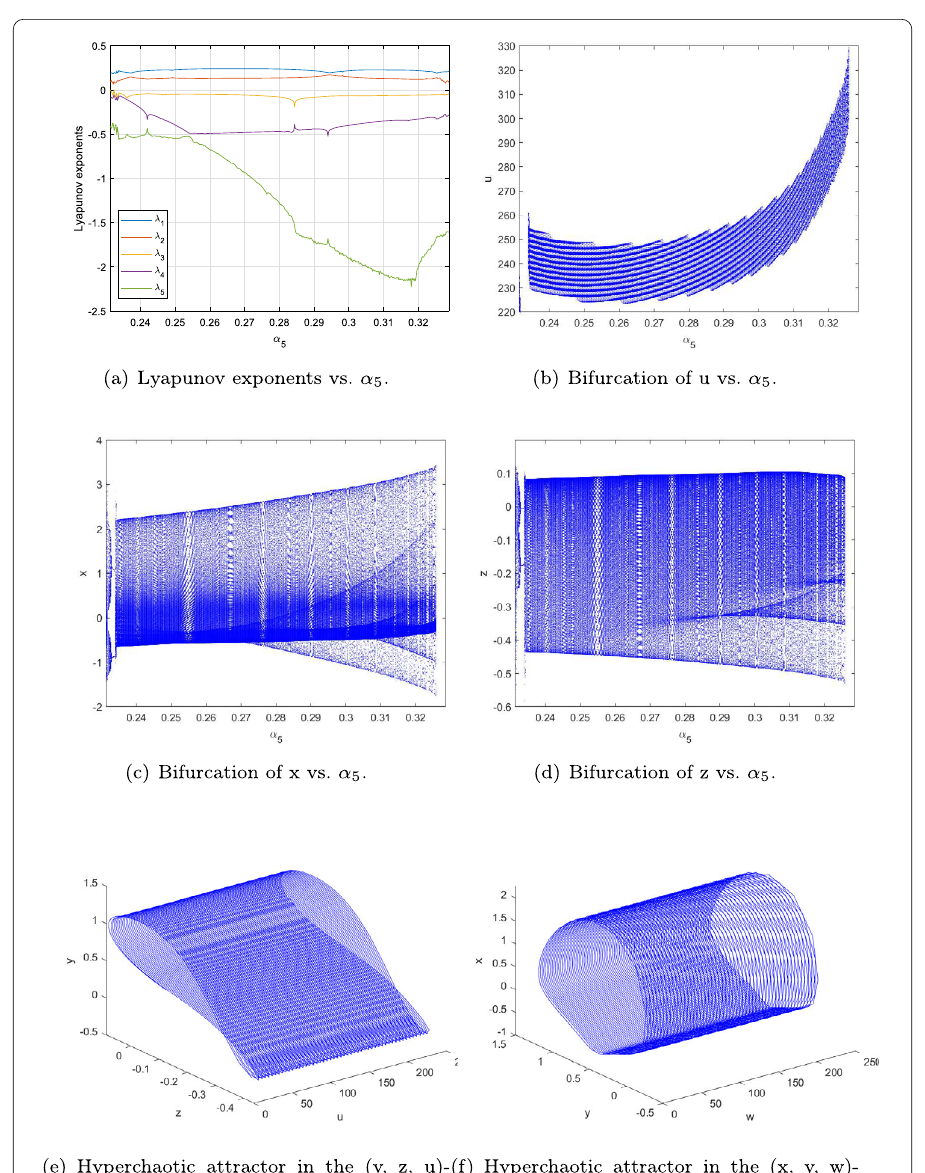
Figure 4 Complex behavior of system (16) with α